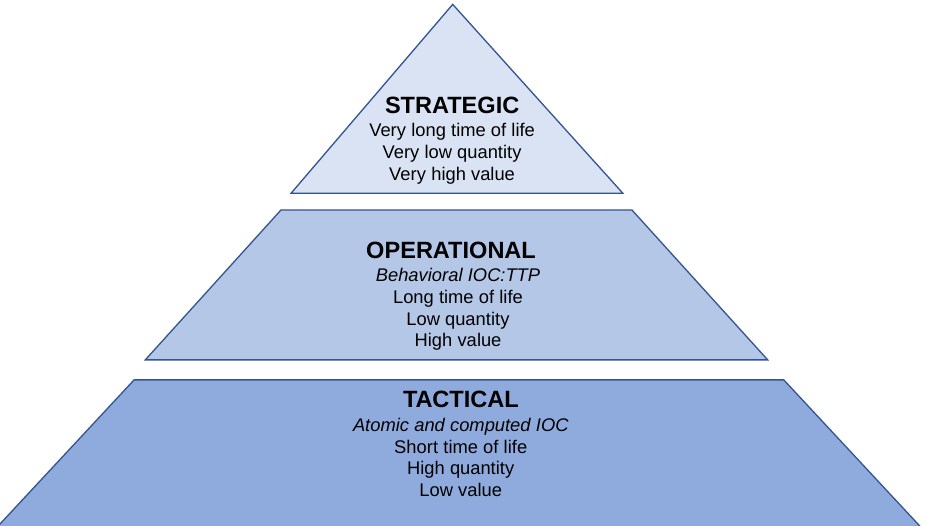
Figure 1. Indicators of compromise and intelligence